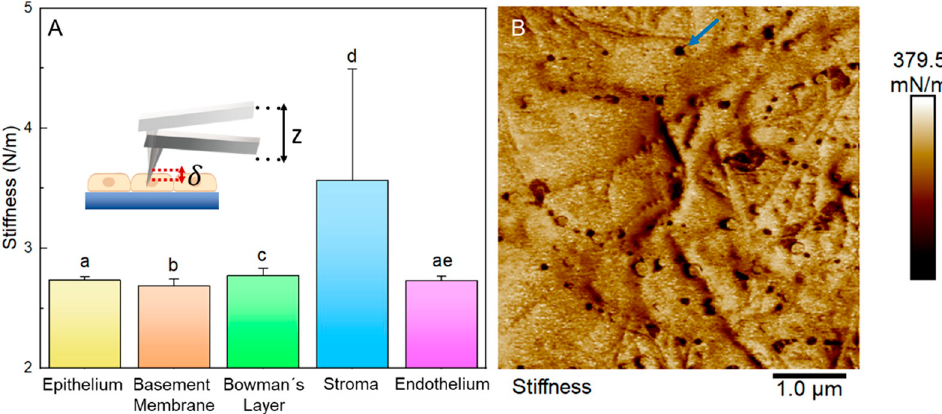
Figure 9. Stiffness values. ( A ) Graphs of local membrane stiffness values from different corneal layers. The inset picture represents the local layer deformation suffered by AFM probe force application. The letters on the graphs indicate the groups with significant differences in the ANOVA test with Tukey’s post hoc for p < 0.05. ( B ) A stiffness map was obtained from a 5 × 5 µm region of the stroma. The blue arrow emphasizes the local difference in stiffness due to macromolecules.